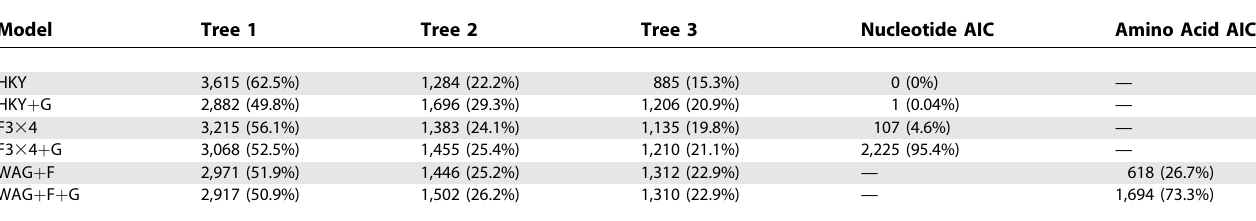
Table 1. Congruence and Fit to Data across Six Models of Evolution Model